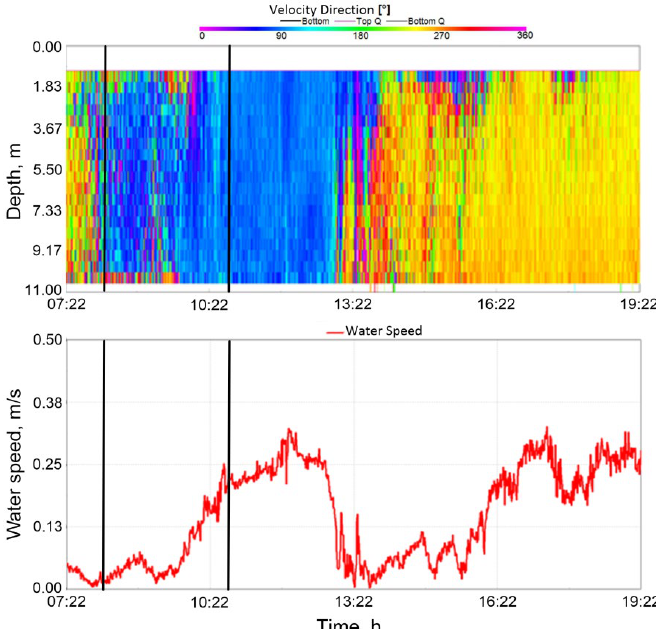
Figure 9. ( a ) Variability of the velocity components on 27 September–8 October 2020. ( b ) Frequency spectra according to the data of zonal velocity component at several depths. Dashed lines show the 95% confidence interval.